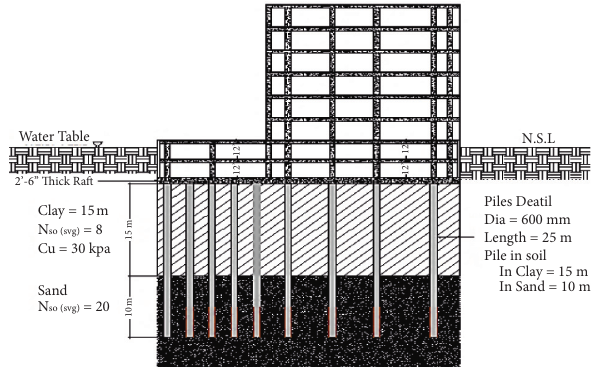
Figure 6: Cross-section of case study 2 piled raft.